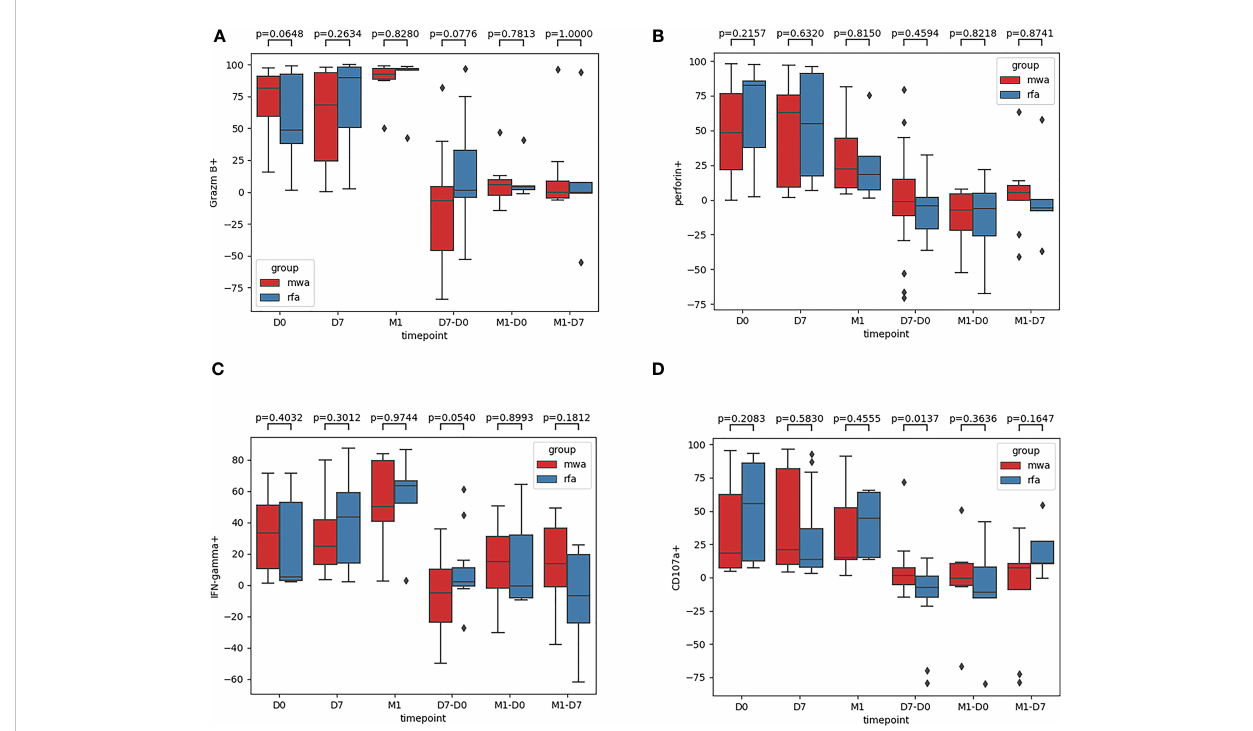
FIGURE 5 The frequencies of Granzyme B (A) , Perforin (B) , IFN- g (C) , CD107a (D) were compared between the RFA group and the WMA group. In D0 (P=0.06, P=0.22,P=0.40,P=0.21), D7(P=0.26,P=0.63,P=0.30,P=0.58), M1(P=0.83,P=0.82,P= 0.97,P= 0.46), D7-D0 (P= 0.08,P= 0.46,P= 0.054,P= 0.012), M1-